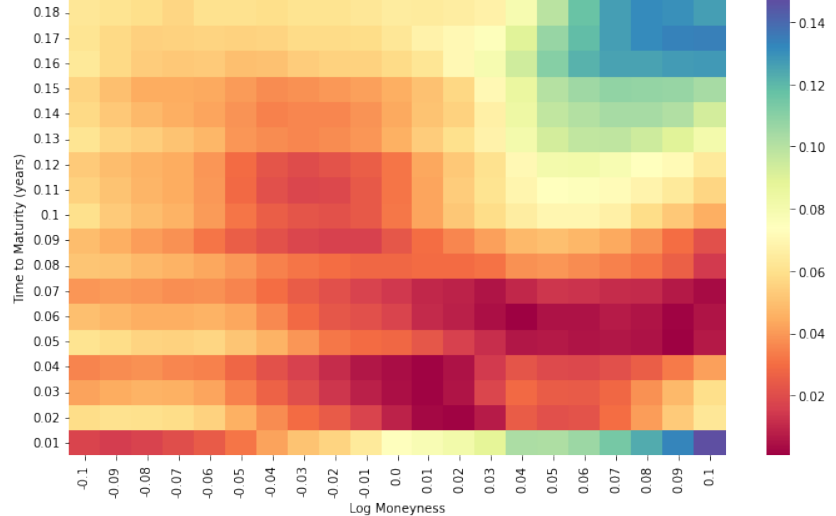
Figure 6. Error between the theorical value and FCNN.